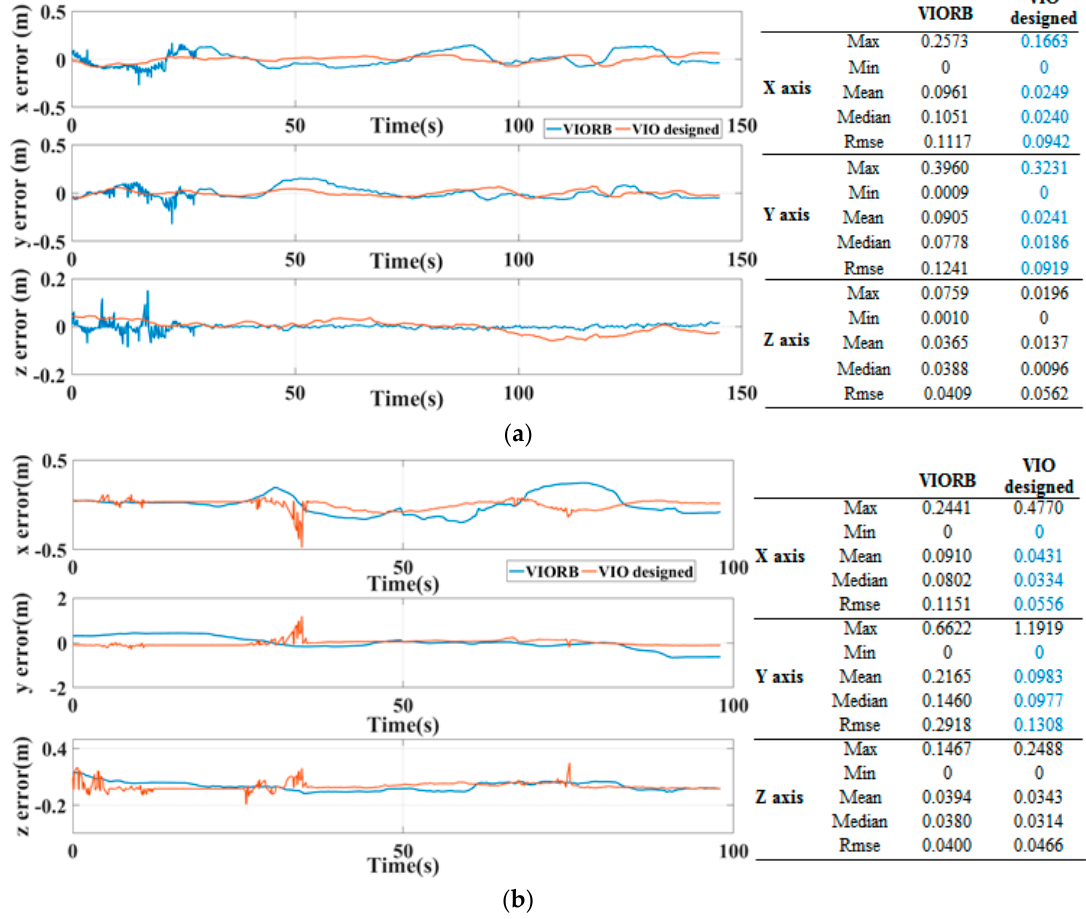
Figure 9. Tri-axial absolute positioning error, ( a ) V1_01_easy sequence; ( b ) MH_04_difficult sequence.